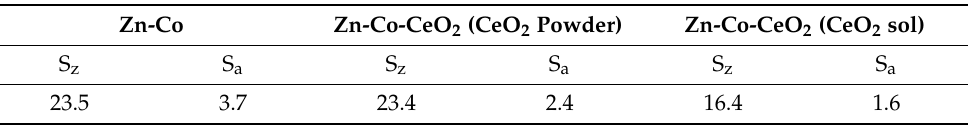
Table 2. Comparison of surface roughness parameters (S z -maximum height (µm); S a -arithmetical mean height (µm)) of examined coatings. Zn-Co